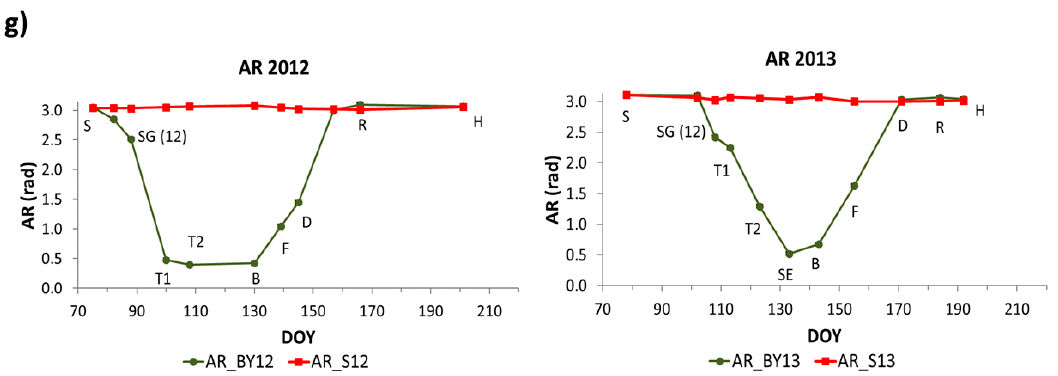
Figure 4. Spectral MODIS indices dynamics: ( a ) NDVI, ( b ) EVI, ( c ) NDWI, ( d ) ANIR, ( e ) SASI, ( f ) AG, ( g ) AR. Average values for the two barley plots (BY) and measured values for the bare soil plot (S) in 2012 and in 2013 in Madrid, Spain.